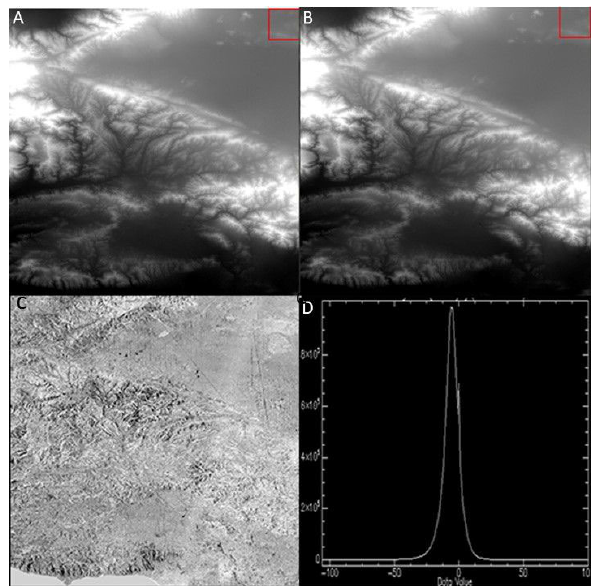
Figure 5 . DEM tile N34W119 (lower left corner): A) ASTER GDEM 3; B) SRTM 3; C) SRTM-GDEM; D) Histogram of